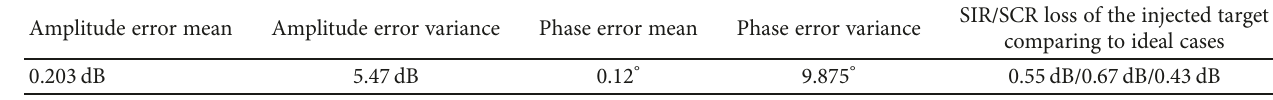
Figure 11: Robustness analysis of amplitude-phase errors with the measured data. Table 4: Injected amplitude-phase error parameters.